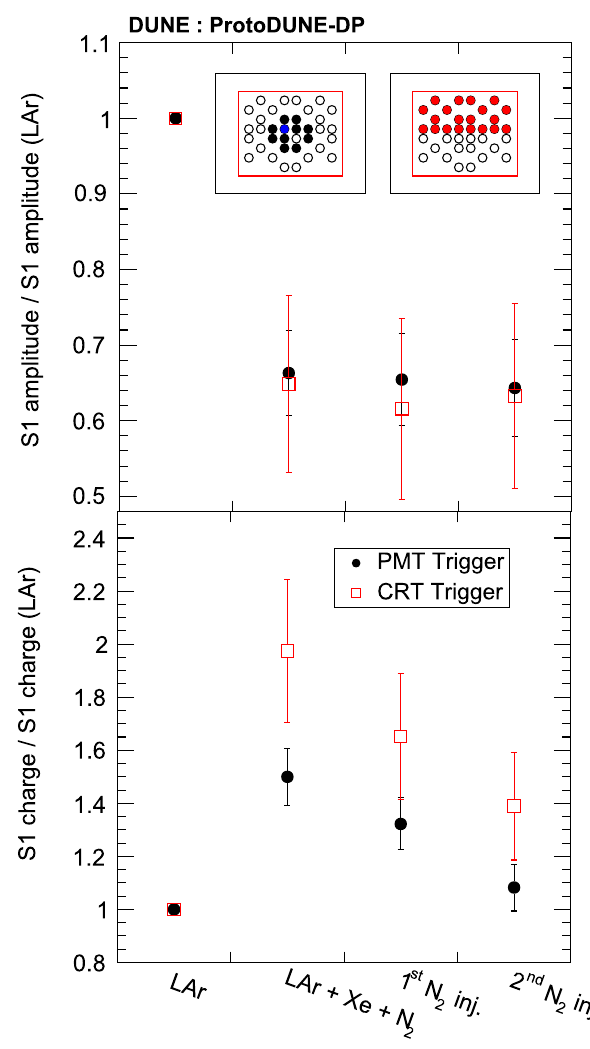
Fig. 27 Ratio of the average S1 amplitude and S1 charge in the three doping concentrations relative to pure LAr. PMT-trigger data are shown inblack,andCRT-triggerinred.OnlyaselectionofPMTsisconsidered for the average. Selected PMTs are marked as black (red) circles in the small diagram for the PMT(CRT)-trigger data. A blue circle marks the trigger PMT in the PMT-trigger diagram. Errors show the STD among the selected PMTs. Xe and N 2 concentrations for each situation are summarized in Table